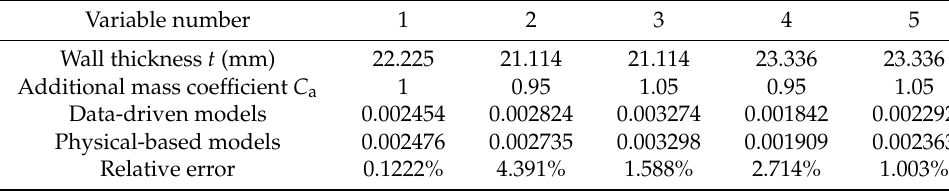
Table 5. Verification of the data-driven model of fatigue.